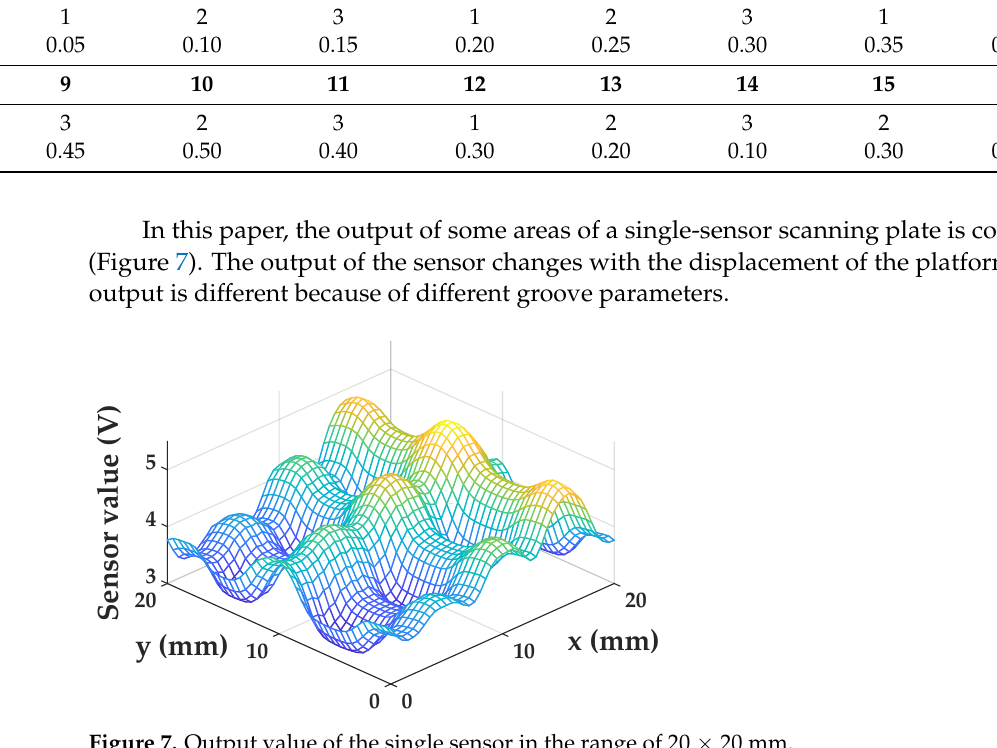
Table 3. Groove parameters in the Y-direction (Starting from Y = 0).